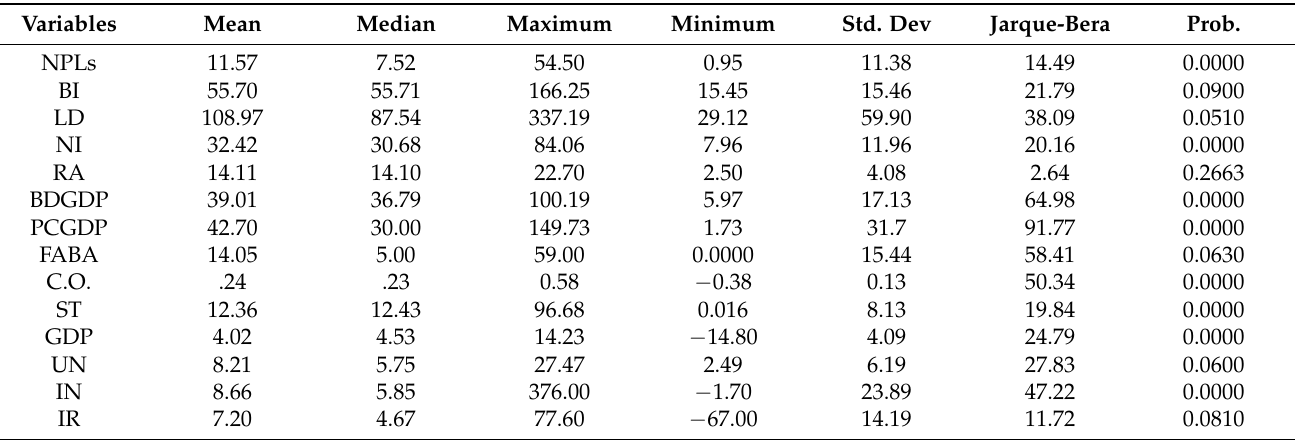
Table 2. Descriptive Statistics of Emerging Countries.